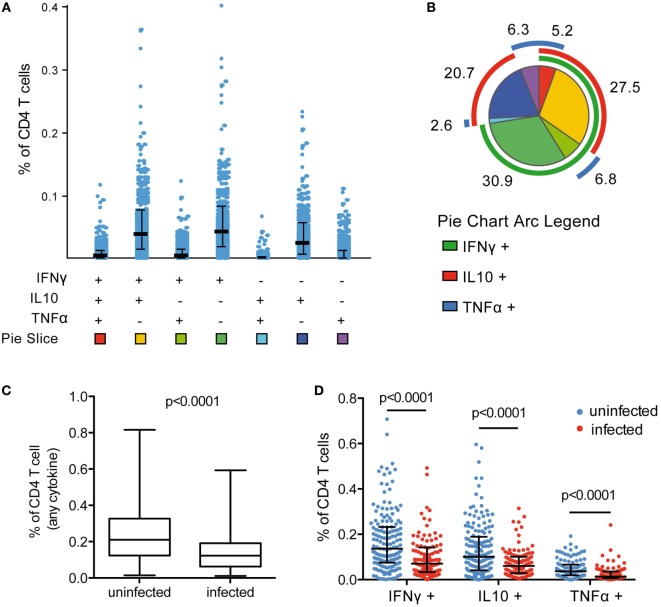
Frequency of Pf CD4 T-cell response reduced during asymptomatic infection. (A)
Pf-specific CD4 T cells producing IFNγ, IL10, and TNFα were measured in 265 children via flow cytometry following incubation of PBMCs with parasite-infected RBCs. Responses were analyzed by Boolean gating in SPICE. (B) The proportion of CD4 T cells producing each cytokine combination was calculated as the percentage of the total parasite-specific CD4 T cells. A pie graph depicting the average proportion of these subsets among all children was generated in SPICE [pie slice colors correspond to the squares at the bottom of (A)]. Mean proportion of each response is indicated. (C,D) Current infection with P. falciparum was assessed via PCR. In currently infected children (n = 106), the total frequency of cytokine-producing CD4 T cells and IFNγ-, IL10-, and TNFα-producing CD4 T cells were all reduced compared with uninfected children (n = 159). Median and IQR are indicated by black bar and whiskers, with p-values for Wilcoxon rank sum test. IFNγ, interferon gamma; IL10, interleukin 10; PBMCs, plasma blood mononuclear cells; PCR, polymerase chain reaction; RBCs, red blood cells; TNFα, tumor necrosis factor alpha.